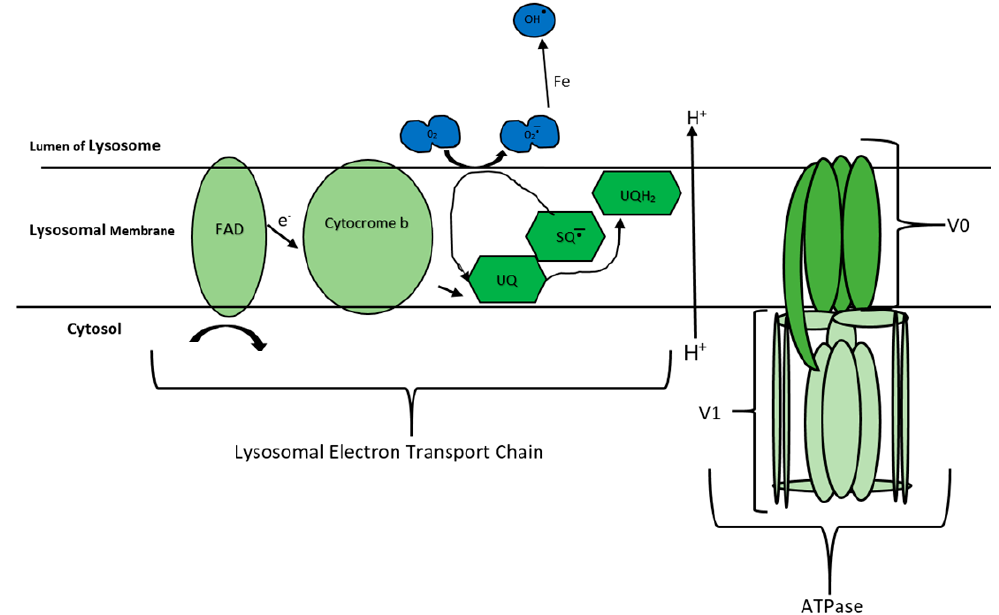
Figure 1. The lysosomal electron transport chain (LETC), adapted from Gille and Nohl [14]. The figure indicates how coenzyme Q 10 (CoQ 10 ) oxidation and reduction are utilised by the lysosome to move H + into the lumen. As eluded to by Gille and Nohl [14]. The oxidation of cytoplasmic nicotinamide adenine dinucleotide (NAD) to NADH + by the flavin-adeine dinucleotide (FAD) present in the lysosomal membrane, leads to the single electron transfer to cytochrome b. Additionally, it has been reported that the oxidation of cytochrome b was found to be proportional to the amount of ubiquinone (UQ) present in the lysosomal membrane. Ubiquinone structure allows for the transfer of two electrons leading to the production of either partially reduced ubisemiqinone or the fully reduced ubiquinol. CoQ 10 ’s structure then allows it to pass freely into the lysosomal lumen, transferring the electrons via molecular oxygen. The basic structure of the lysosomal ATPase is also outlined and is adapted from the paper by Zoncu, et al. [15]. The structure and function of this ATPase is similar to that found in the mitochondria, although it is involved in the hydrolysis of ATP rather than the synthesis of this molecule. It consists of 13 subunits and is divided into 2 domains, V0 and V1. The V0 domain is involved in translocating protons (H + )’s across the lysosomal membrane and into the lumen. The V1 domain is involved in the hydrolysis of ATP which provides the energy for the translocation of H + ions against the H + concentration gradient for transport into the lumen. [15,16]. Abbreviations: FAD, flavin-adeine dinucleotide; UQ, ubiquinone; SQ, semiquinone.